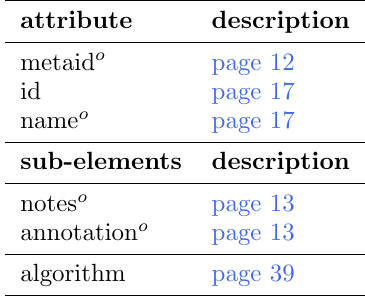
Table 2.13: Attributes and nested elements for simulation. o denotes optional elements and attributes.